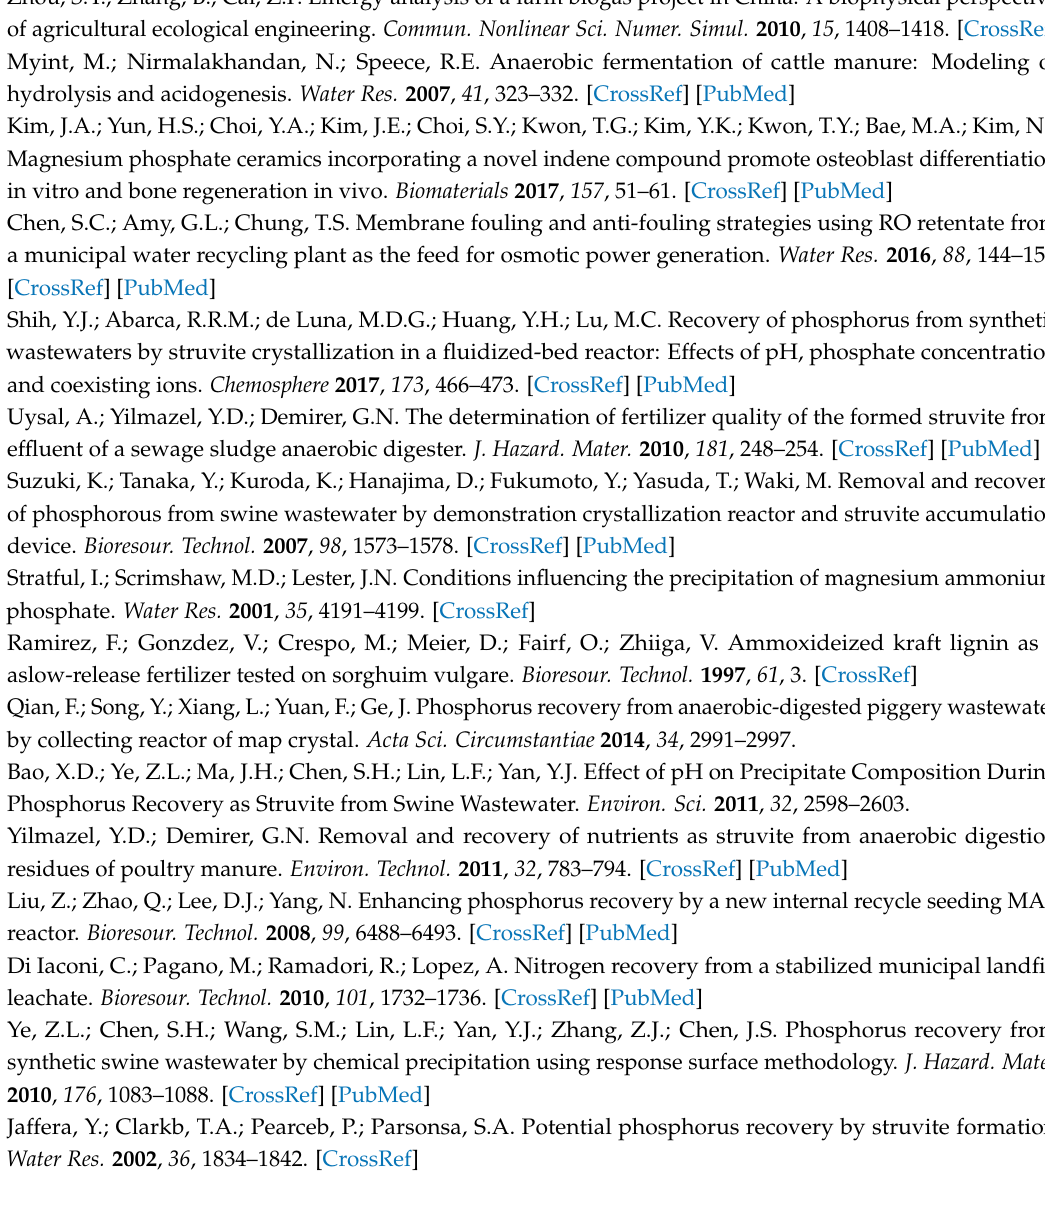
s1, Figure S1: Schematic diagram of the pot trial tests, Figure S2, Residual distribution of the recovery rate of P (a) and N